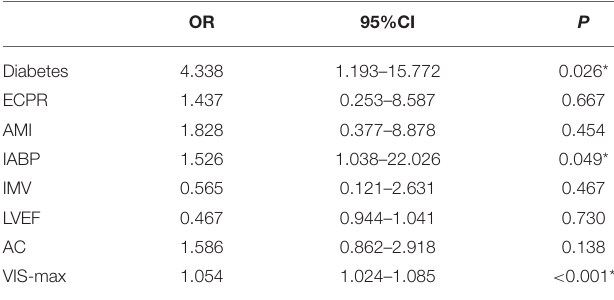
TABLE 4 | Multivariate analysis of limb ischemia complications in V-A ECMO patients.